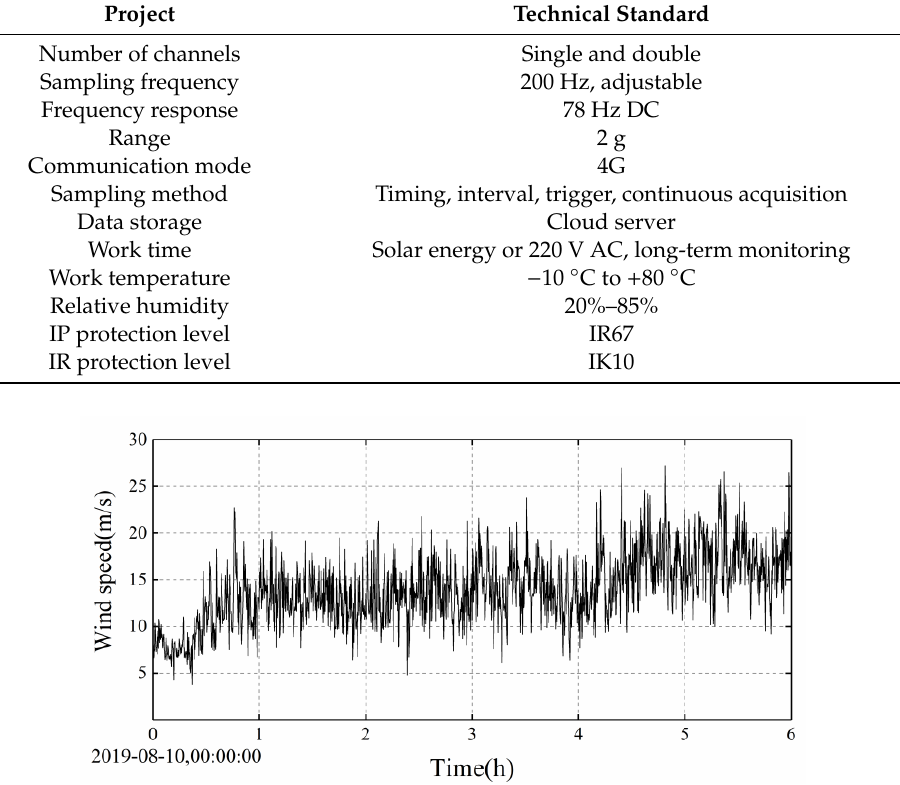
Figure 3. Sensor field installation on the Jintang Bridge. Table 1. Wireless acceleration node TZT3805.